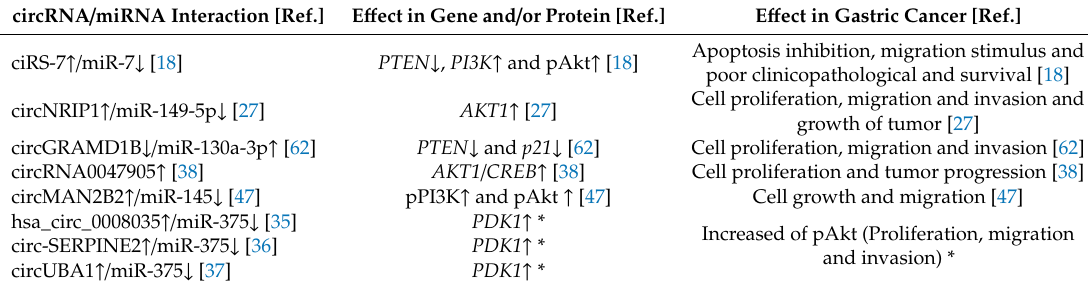
Table 2. circRNA-miRNA interactions that a ff ect PI3K / Akt signaling pathway in gastric cancer. circRNA / miRNA Interaction [Ref.] E ff ect in Gene and / or Protein [Ref.]